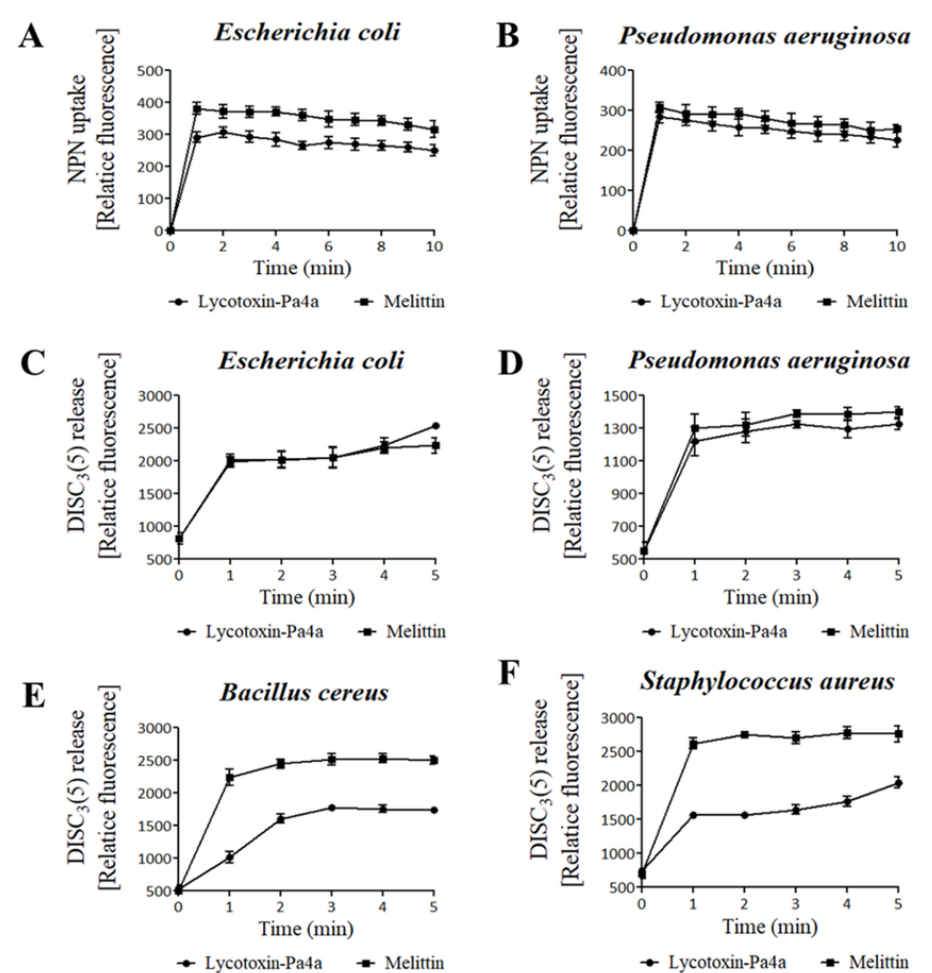
Figure 3. E ff ects of Lycotoxin-Pa4a on bacterial membrane. ( A , B ) NPN uptake showed outer membrane disruption by Lycotoxin-Pa4a (4 µ M) in both E. coli and P. aeruginosa. The same concentration of melittin was used as control. ( C – F ) Depolarization of the bacterial cytoplasmic membrane was measured using DISC 3 (5) dye; 4 µ M of Lycotoxin-Pa4a and melittin exposure increased fluorescence intensity for all the strains within 5 min.